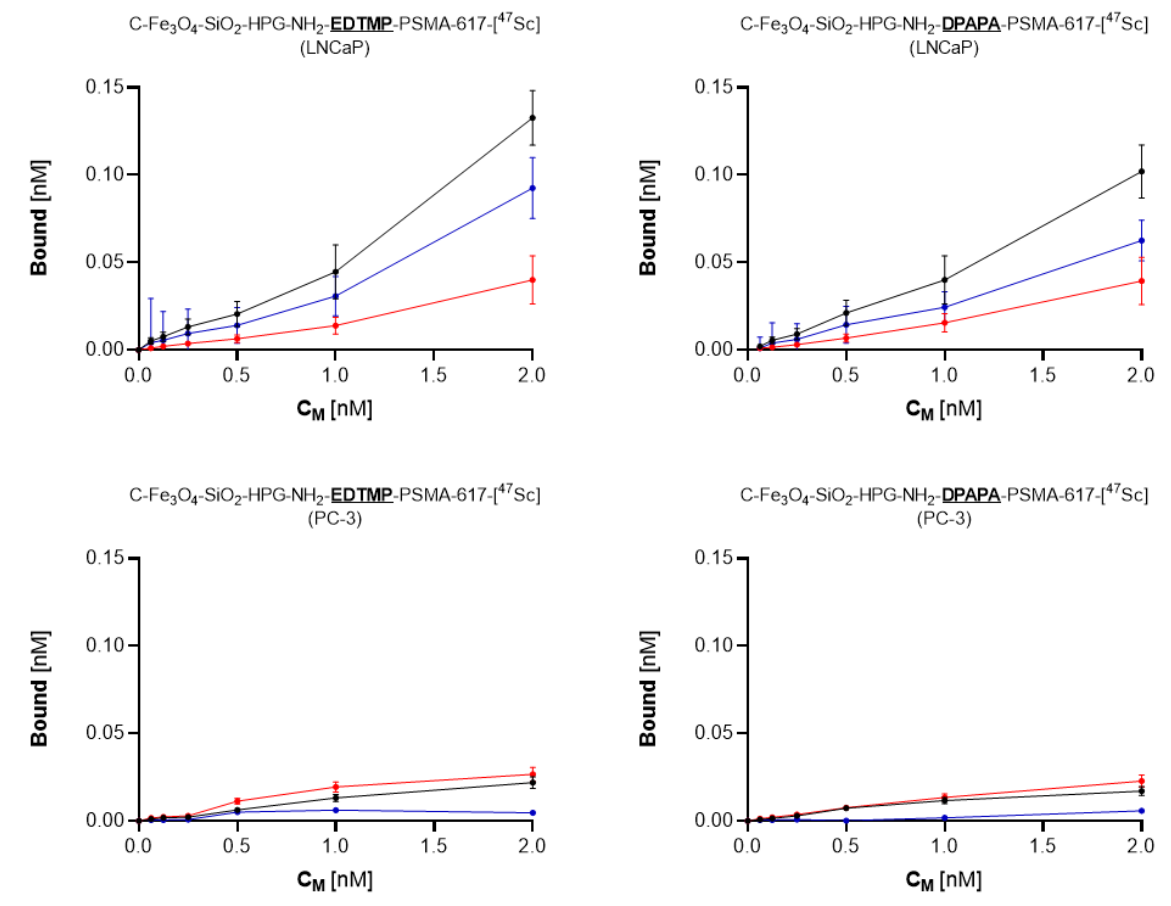
Figure 5. Receptor binding affinity studies of 44 Sc labeled EDTMP- and DPAPA-based radiobioconjugates. Upper graphs show data for LNCaP cells; bottom graphs show data for PC-3 cells.